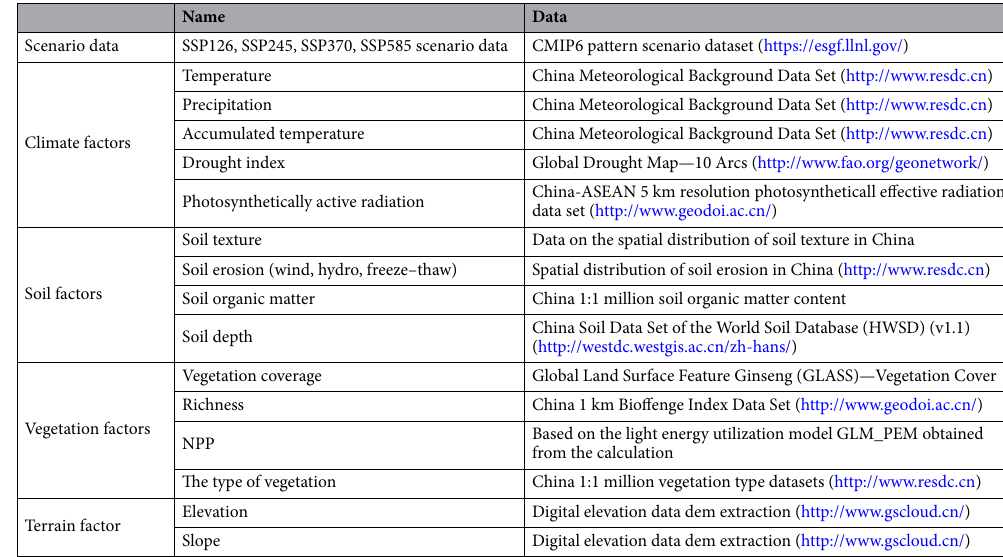
Table 1. Data sources of ecological risk assessment indicators for the